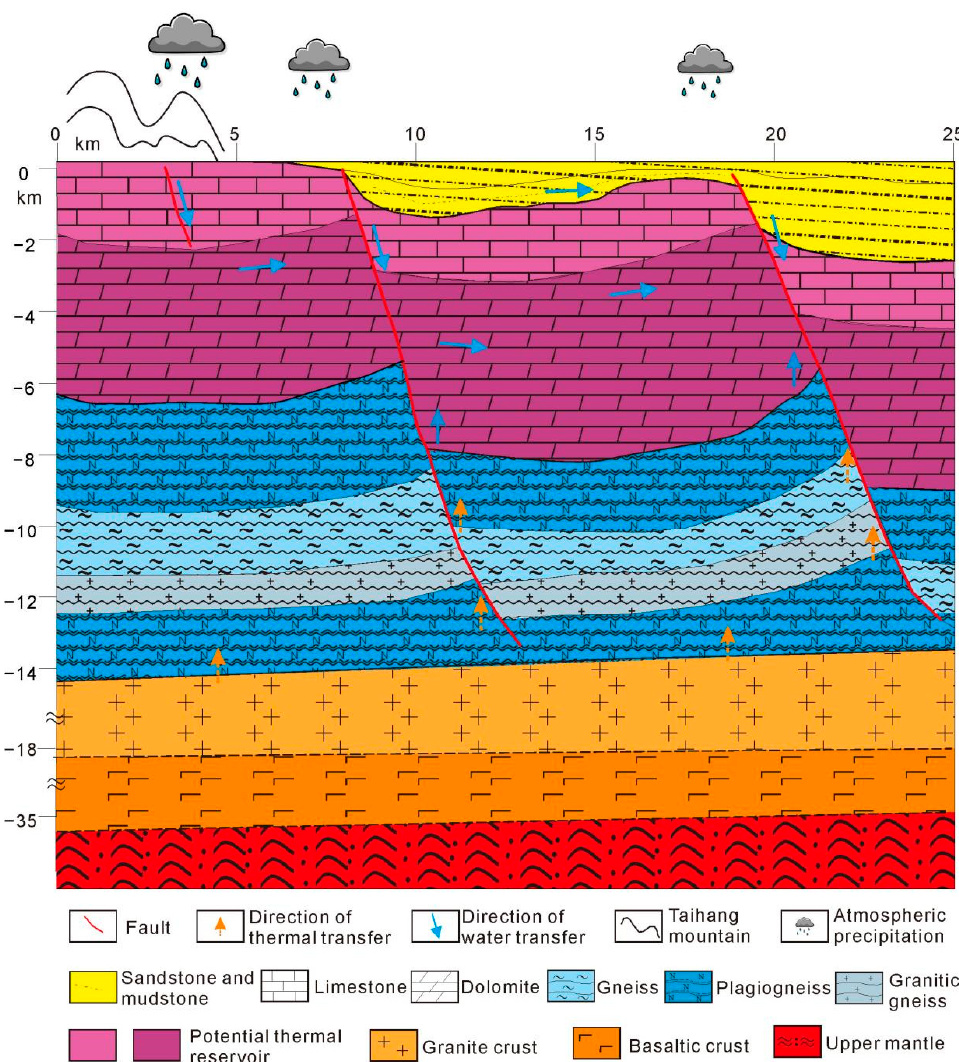
Figure 10. Geothermic genetic model of the Shunping area.